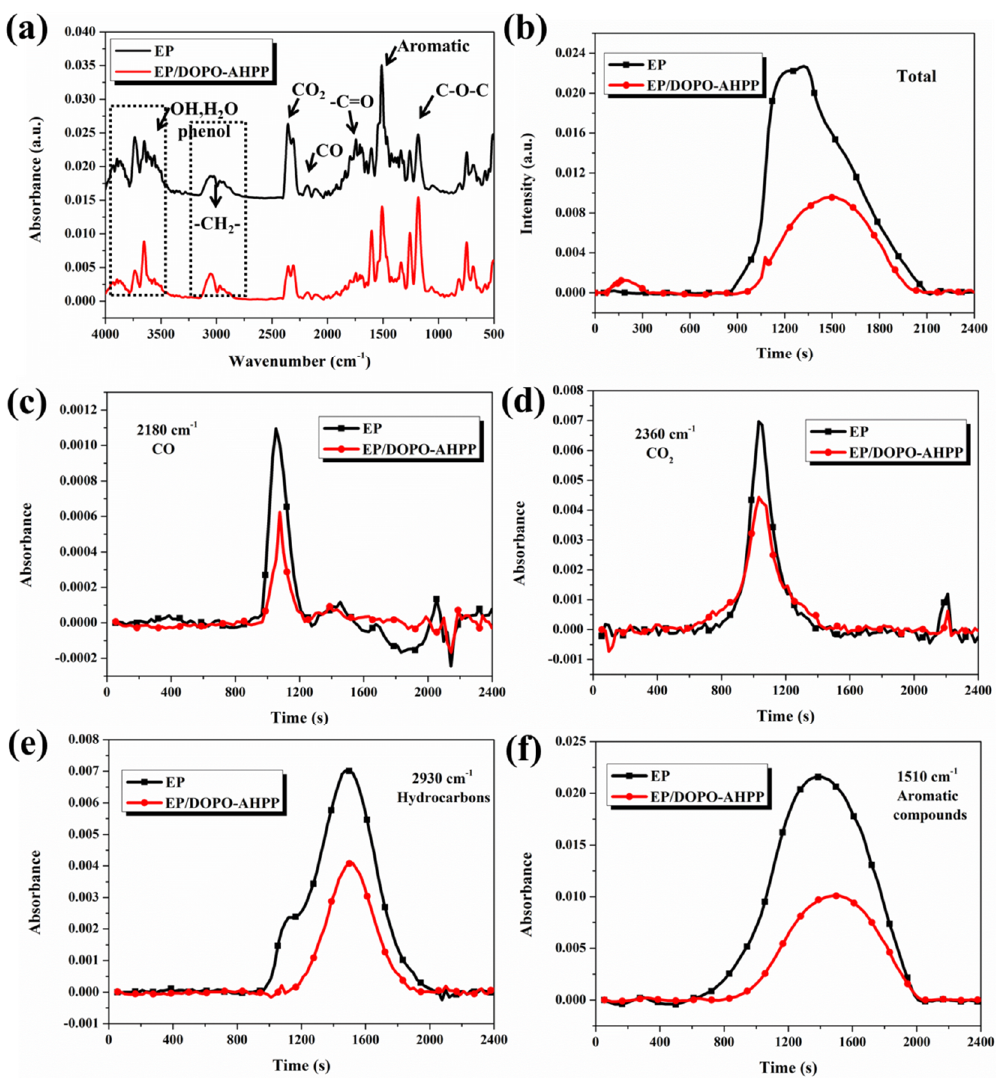
Figure 5. FTIR spectrum of pyrolysis products at the maximum decomposition rate ( a ); Gram–Schmidt curves ( b ) and absorbance of pyrolysis products in nitrogen atmosphere for EP and EP-4 versus time. CO ( c ); CO 2 ( d ); hydrocarbons ( e ); and aromatic compounds ( f ).